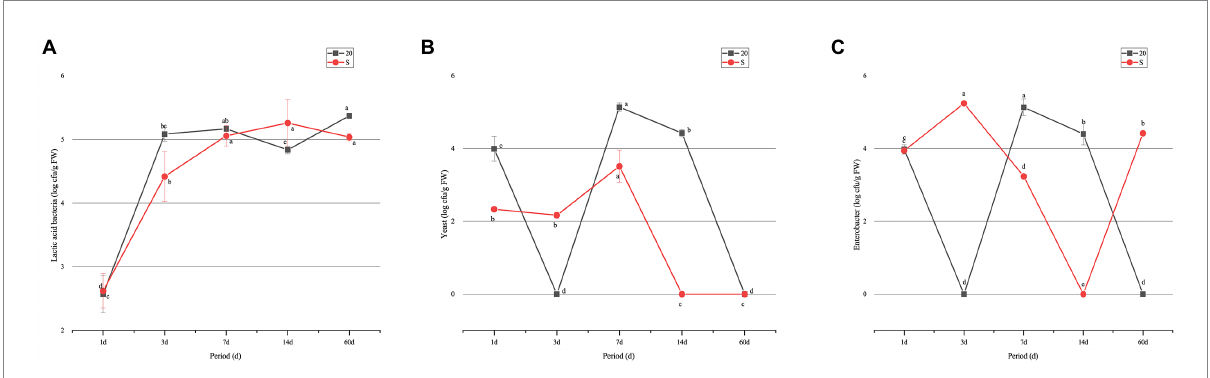
FIGURE 1 Change of microorganism counts in oat silage ensiled for 60 days: (A) lactic acid bacteria; (B) yeast; and (C) Enterobacter. a–e: means are significant different at 0.05 level. S, freeze–thaw condition, alternating 20 ° C and − 5 ° C every 12